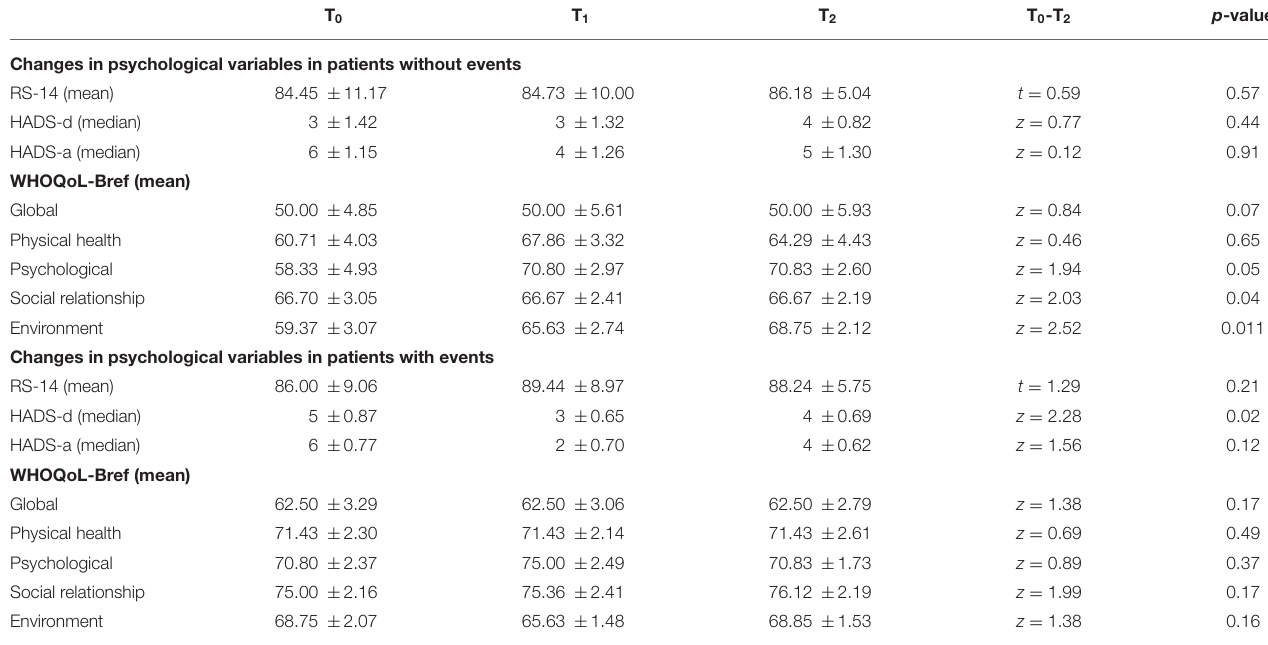
TABLE 4 | Changes in psychological variables in patients without and with events (ICD shocks and/or hospitalization). T 0 T 1 T 2 T 0 -T 2 p